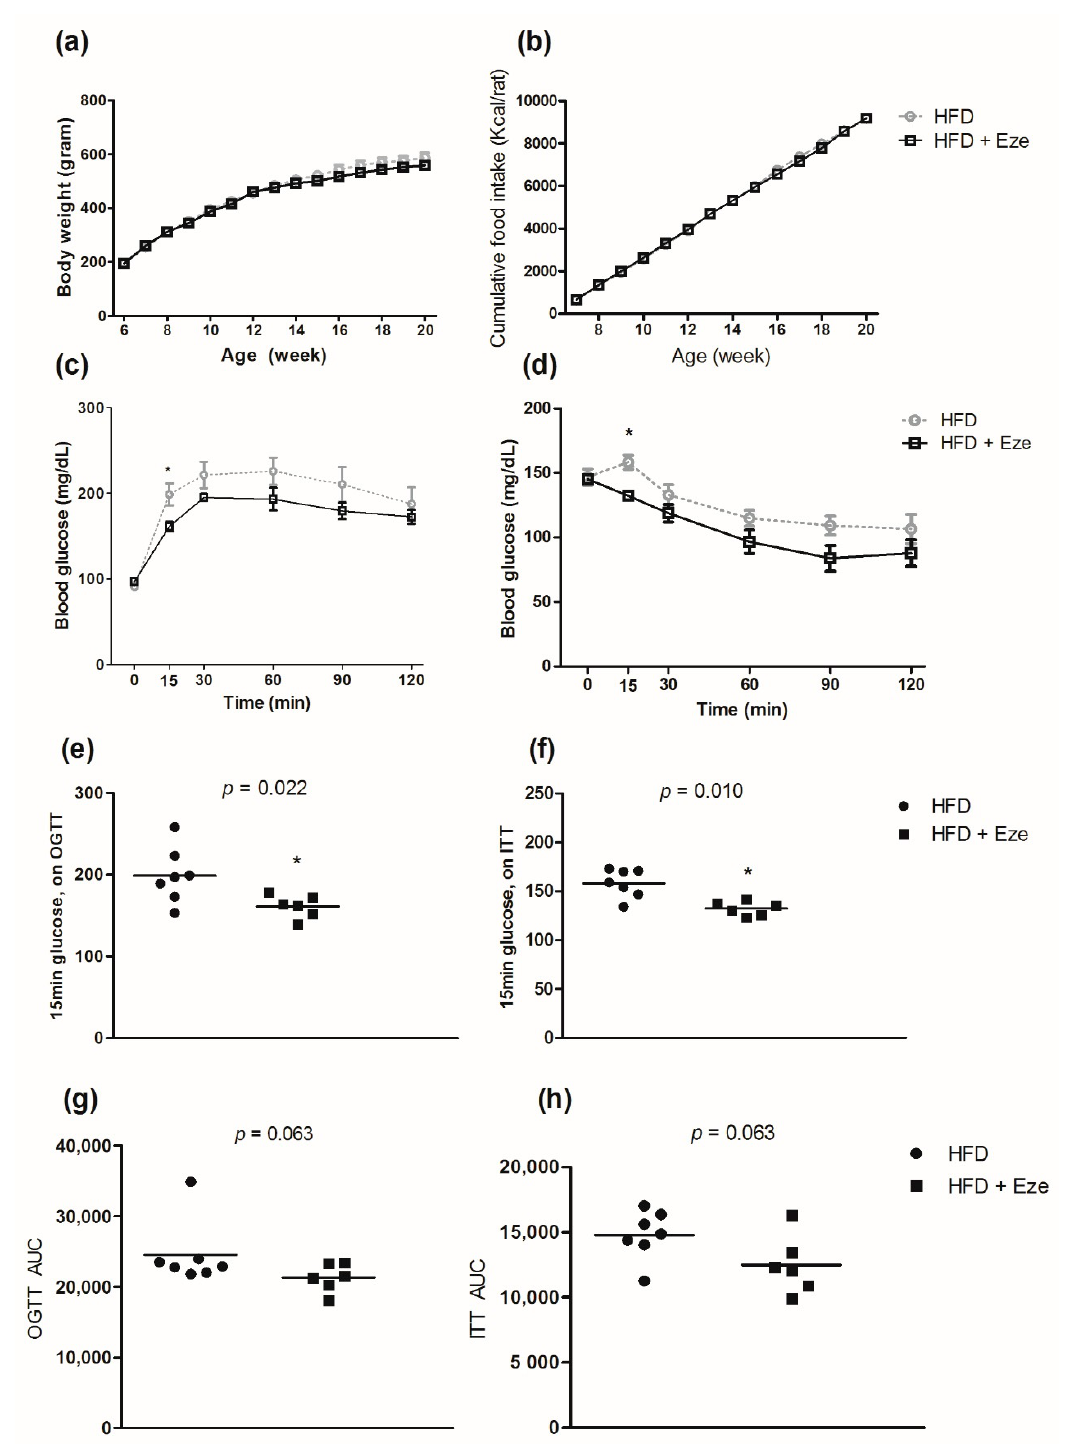
Figure 1. Effects of ezetimibe on oral glucose tolerance test (OGTT) and insulin tolerance test (ITT). ( a ) Gain in body weight, ( b ) cumulative food intake (Kcal / animal) ( c ) OGTT, ( d ) ITT, ( e ) OGTT after 15 min of glucose administration, ( f ) ITT after 15 min of glucose administration, ( g ) AUC of OGTT, and ( h ) AUC of ITT. Compared using the Wilcoxon-Mann-Whitney U test; * p < 0.05. OGTT; oral glucose tolerance test, ITT; insulin tolerance test.